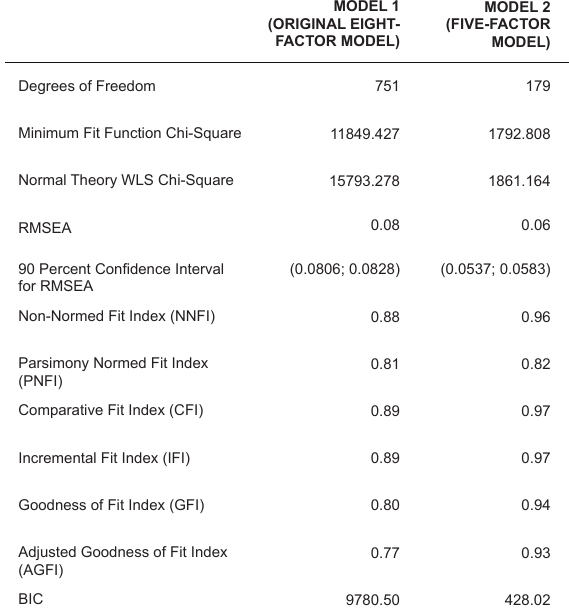
TABLE 5 Fit indices for Model 1 and Model 2 (n = 2